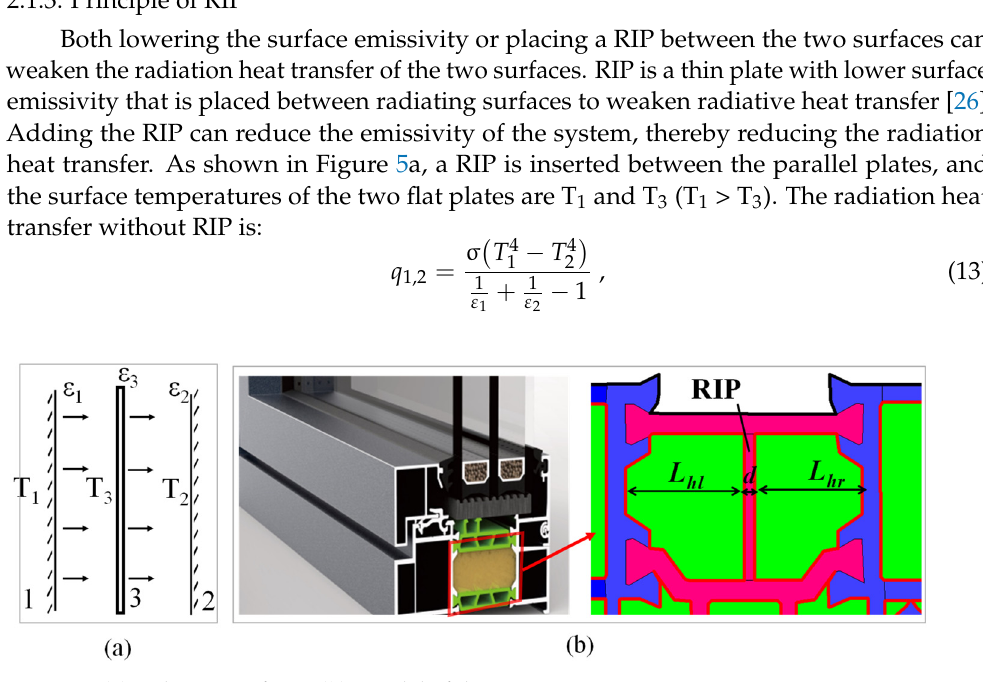
Figure 5. ( a ): Schematic of RIP; ( b ): Model of the RIP.